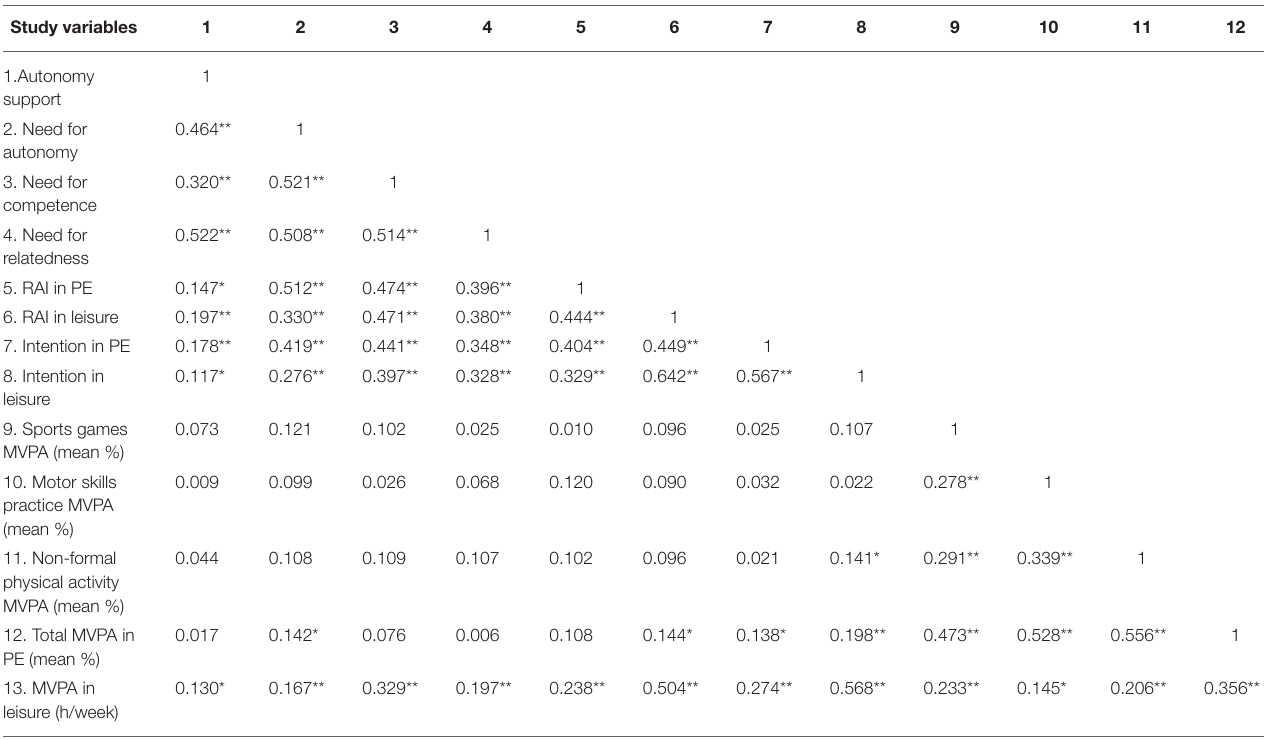
TABLE 2 | Correlations between study